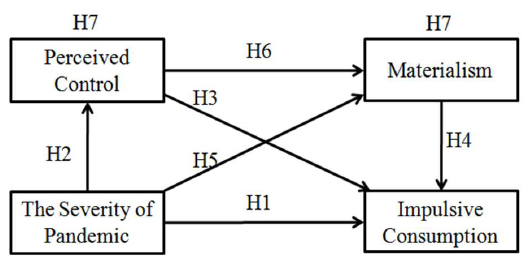
Figure 1. Theoretical model.